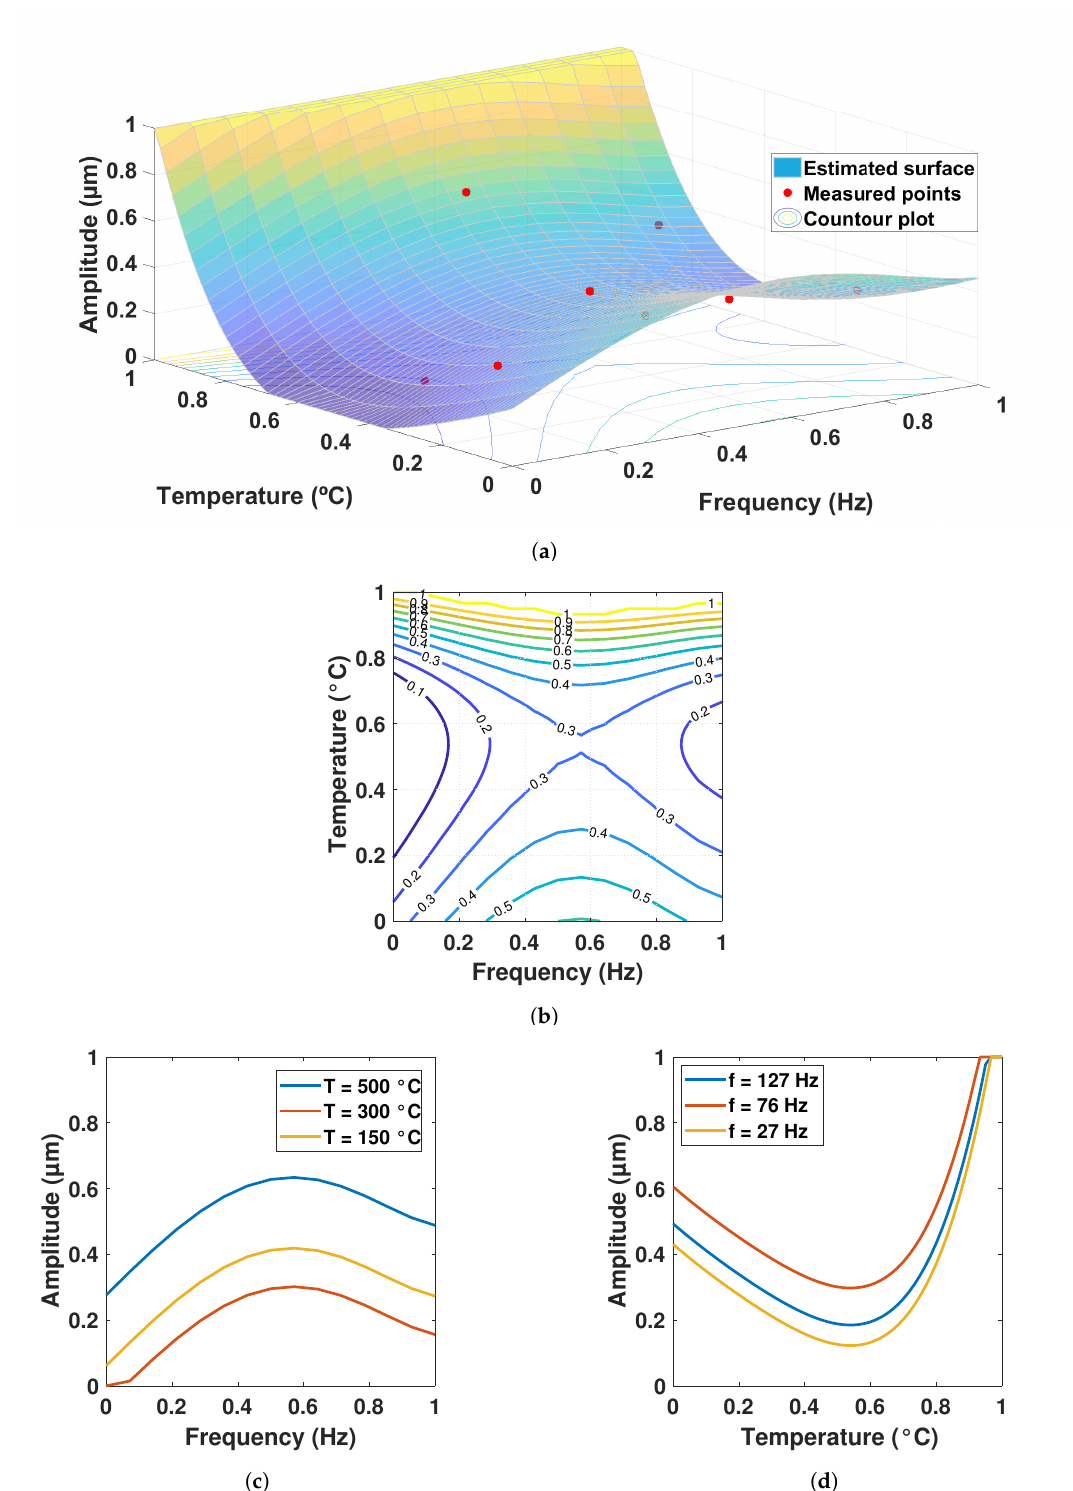
Figure 5. Results from the 5th order polynomial using the 8-point sample: ( a ) Surface response model fitting the sample; ( b ) Contour plot from the surface response model; ( c ) Amplitude vs. frequency when setting the nominal temperature values; ( d ) Amplitude vs. temperature when setting the nominal